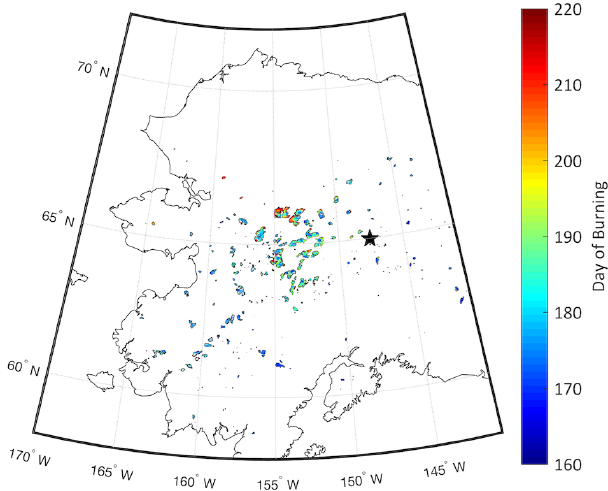
Figure 1. The location of wildfires in Alaska during 2015, with color representing the day of burning estimated from the Alaska Fire Emissions Database (AKFED). The black star denotes the lo- cation of the CRV